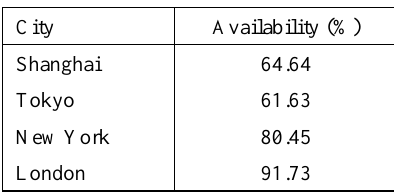
Table 6. The availabilities of the study